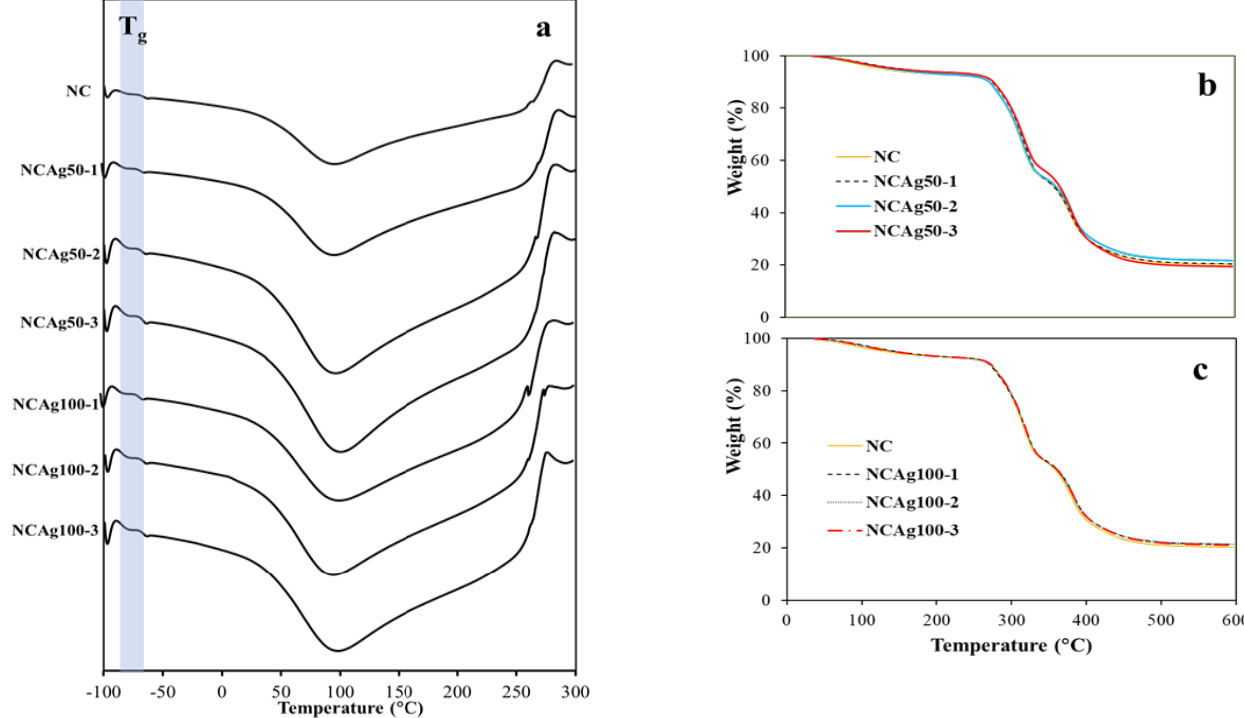
Figure 7. DSC thermograms of NCAg50 and NCAg100 films ( a ); TGA curves of NCAg50 films ( b ) and NCAg100 films ( c ) as compared to NC film.